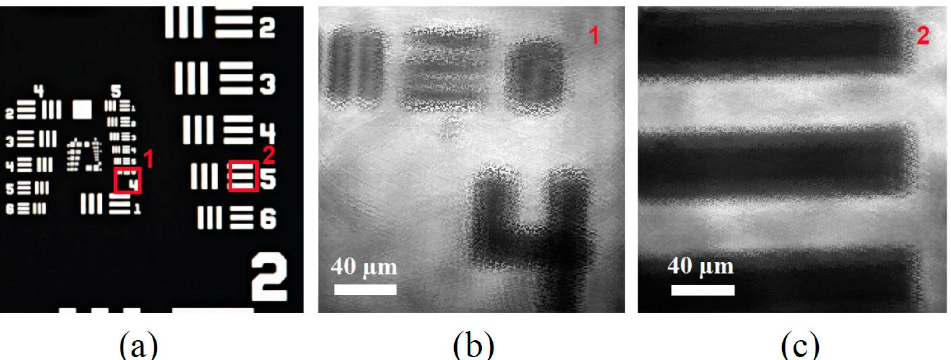
Figure 3. ( a ) Thorlabs 1951 USAF resolution target; ( b ) The image of the stripes of element 6 in group 5; ( c ) The image of the stripes of element 5 in group 3; FOV is 200 μ m × 200 μ m for both